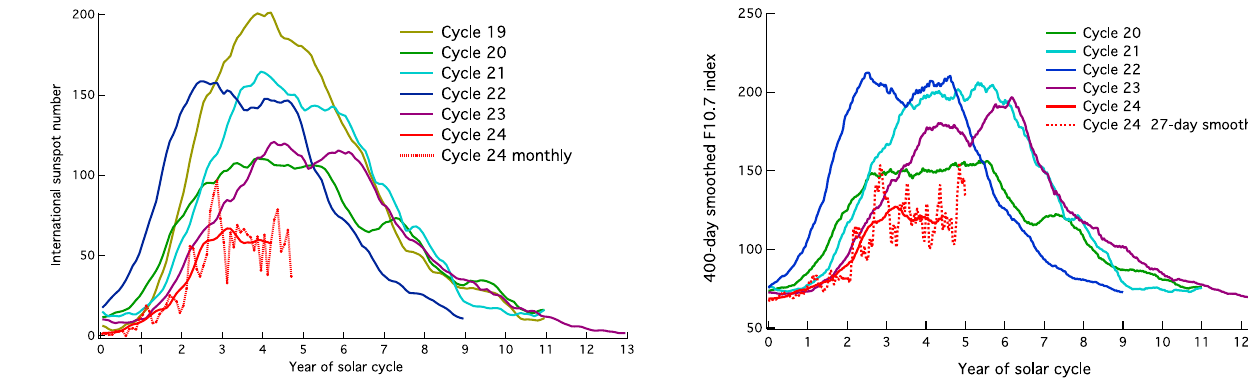
Figure 7. Solar F10.7 index since the beginning of SC20. The 400- day (approximately 13-month) smoothed F10.7 index for each cycle is shown (solid lines), and for SC24 the 27-day smoothed F10.7 index till December 2013 is displayed (dotted line) as well.